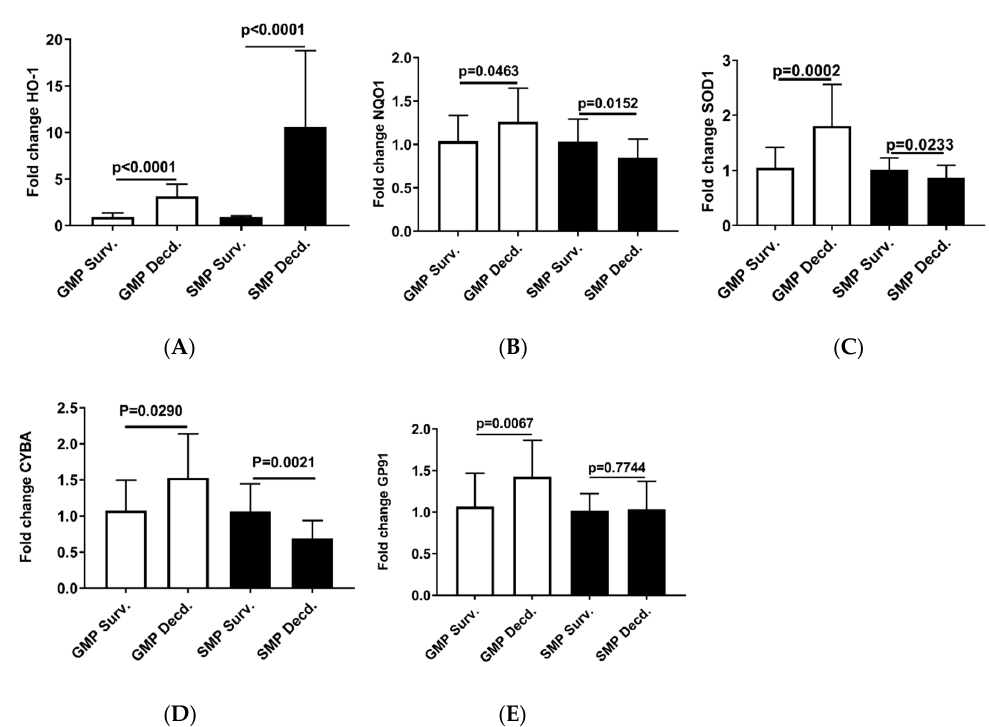
Figure 6. Real-time PCR analysis of Nrf2 target genes in heart cDNA prepared from irradiated survivor and decedent GMP/SMP. ( A–E ) Normalized quantitative PCR analysis showing the fold change in the expression of HO-1, NQO1, SOD1, CYBA, and GP91 in the hearts of irradiated survivor or decedent GMP/SMP. The y-axis represents the fold changes in expression of decedent animals genes compared with the survivors.